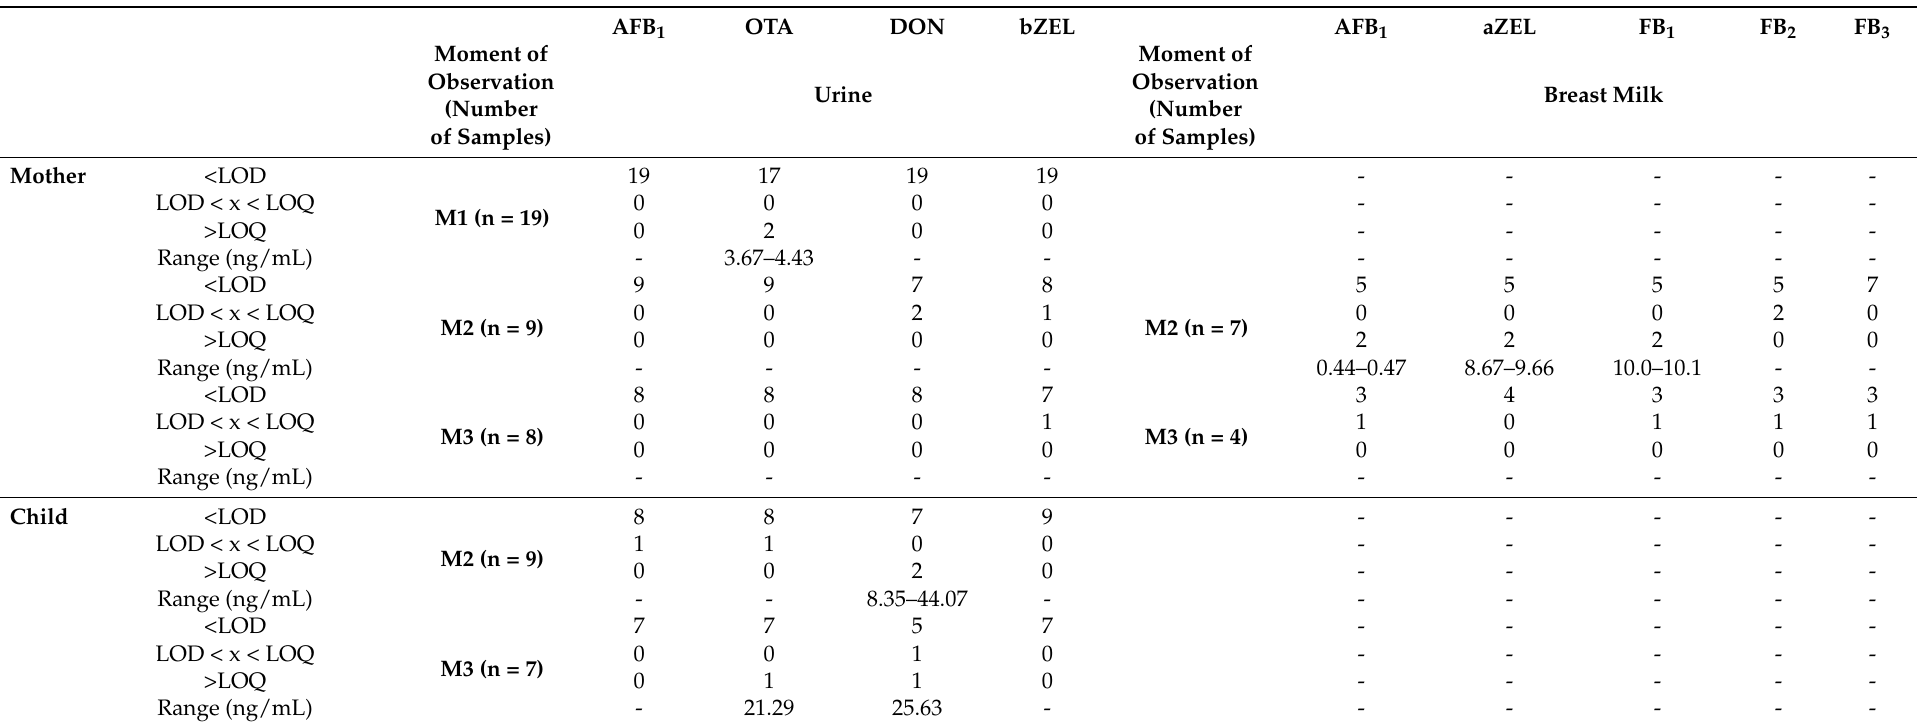
Table 2. Biomarkers of exposure to mycotoxins determined in urine and breast milk samples of the 19 mother–child pairs participating in the earlyMYCO pilot study. Results are presented as biomarker volume-weighted concentration